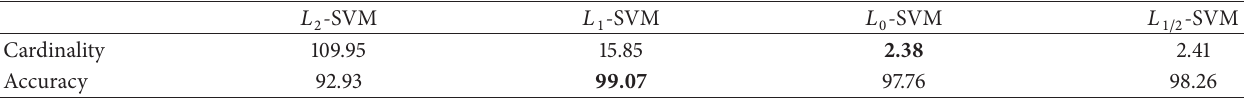
Table 3: Average results over 10 artificial data sets with varies